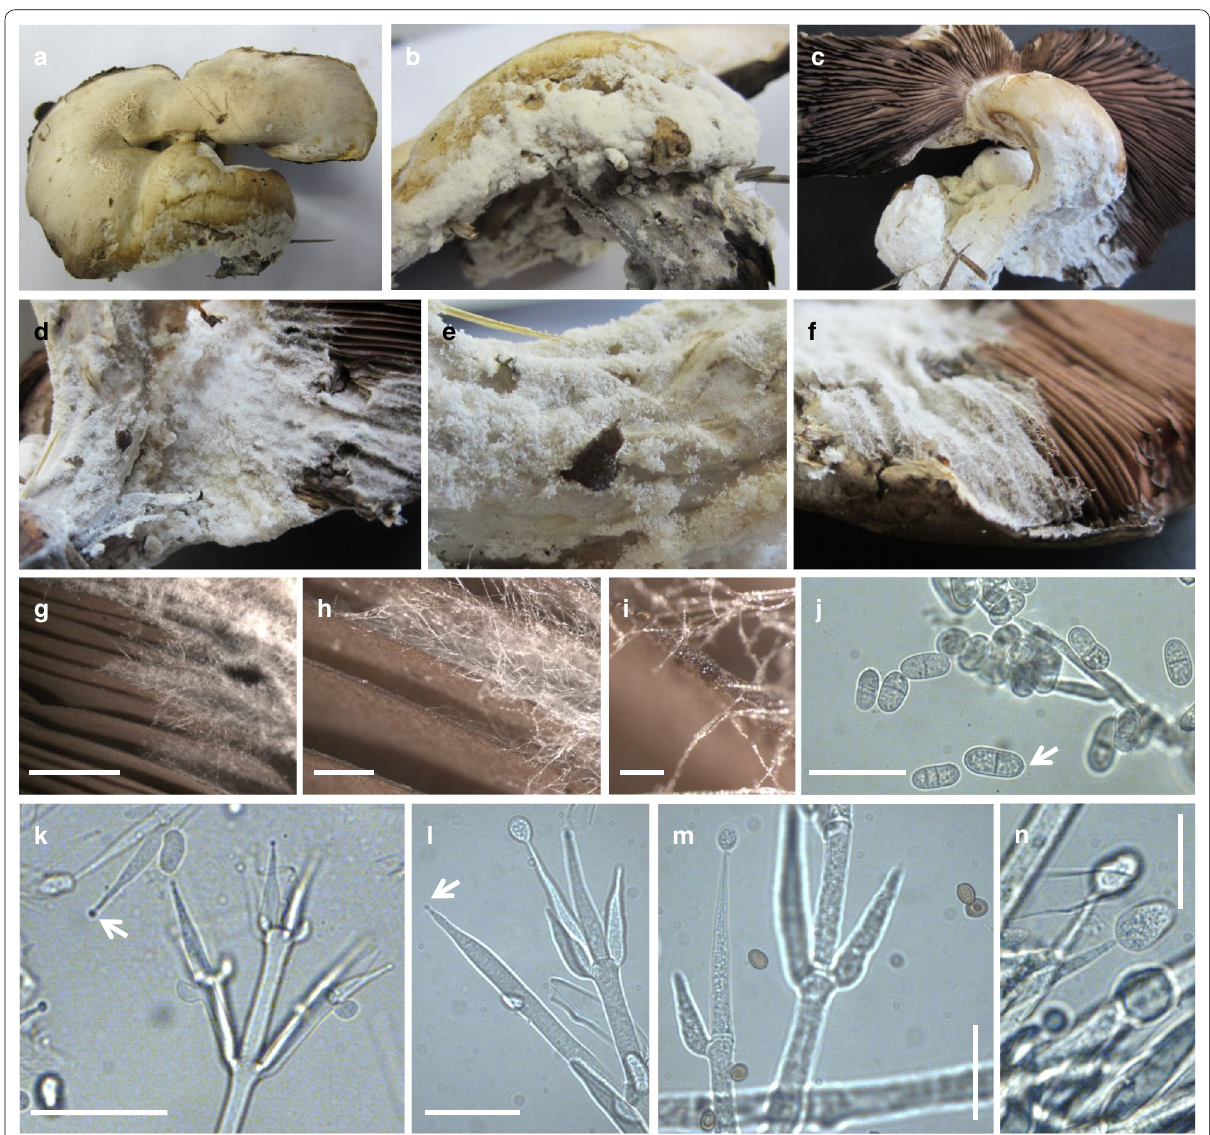
Fig. 2 Diseased crippled Agaricus xanthodermus fruiting body. a , b The upper surface of the cap, c , d the surface of the bended stipe, and e , f parts of the lamellae are overgrown by foreign mycelium with conidiophores visible as white flocks in the aerial mycelium ( d ). g – i For infestation of the lamellae, the foreign mycelium grew first over their edges, with conidiophore production starting about 6 to 7 mm behind the growth front ( g ; see white flocks at the right side of the photo). j – n Conidia and conidiophores in mycelial samples taken for microscopy from the lamellae. Note the blastic generation of conidiospores at the tips of phialides (arrows in k – l ) and dehiscence scars (basal hilum) at the spores (see arrow in j ) and also the small brown basidiospores of the host ( m ). Sizes bars correspond to 5 mm ( g ), 1 mm ( h ), 200 µm ( i ), 50 µm ( k ) and 20 µm ( j , l – n